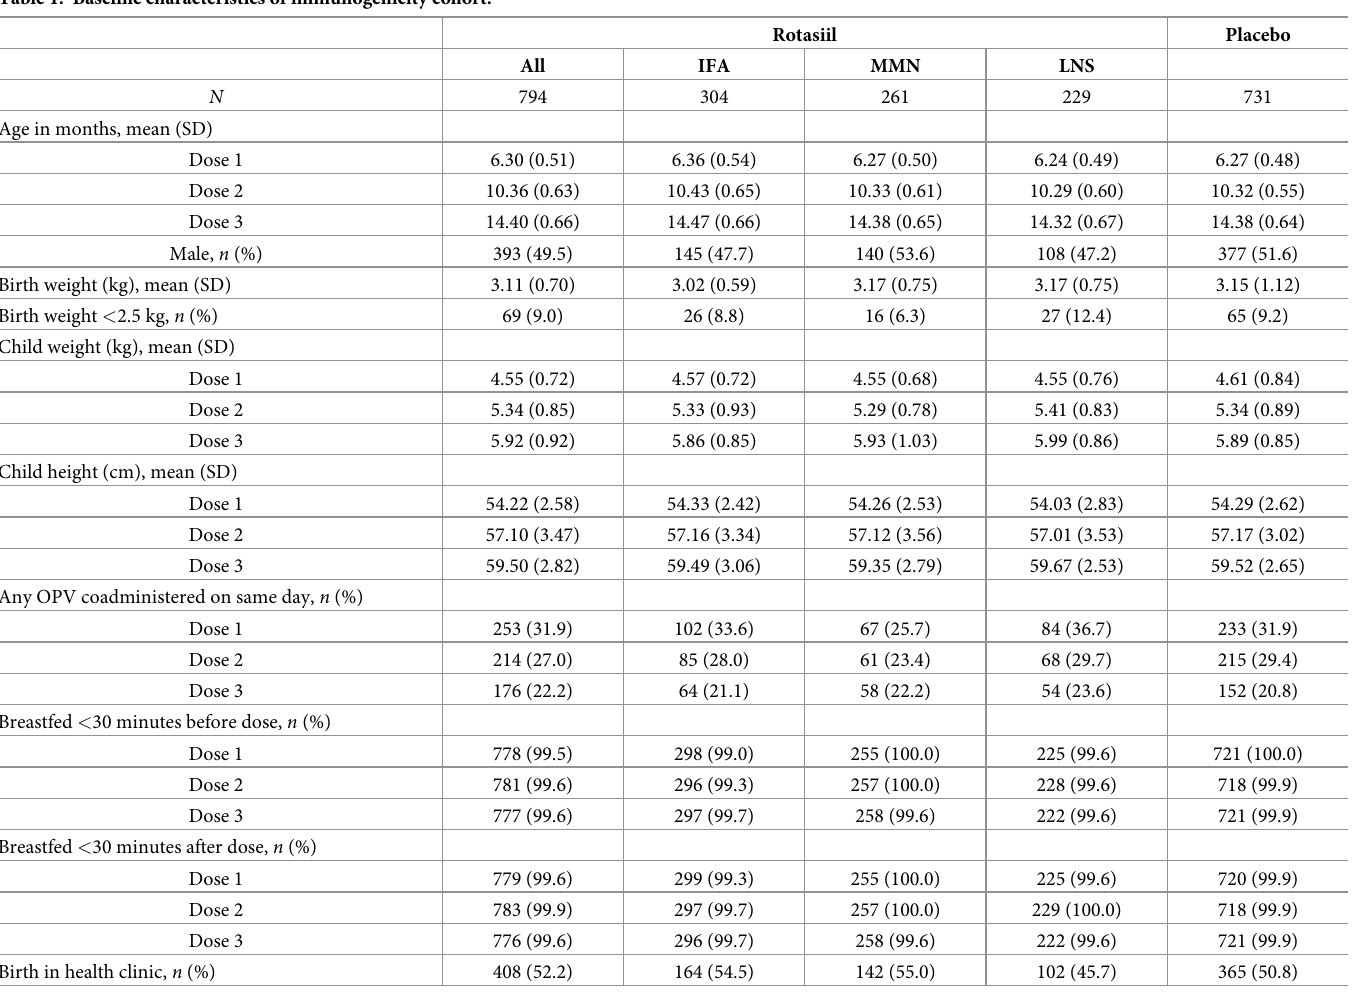
Table 1. Baseline characteristics of immunogenicity cohort.